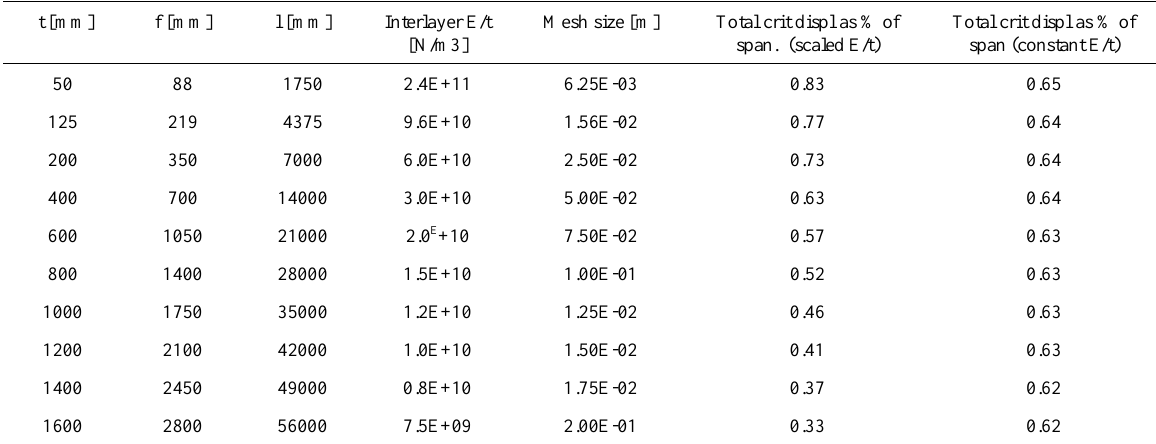
Table 5 Results of geometrical scaling. Ratio t/f and t/l and E are kept